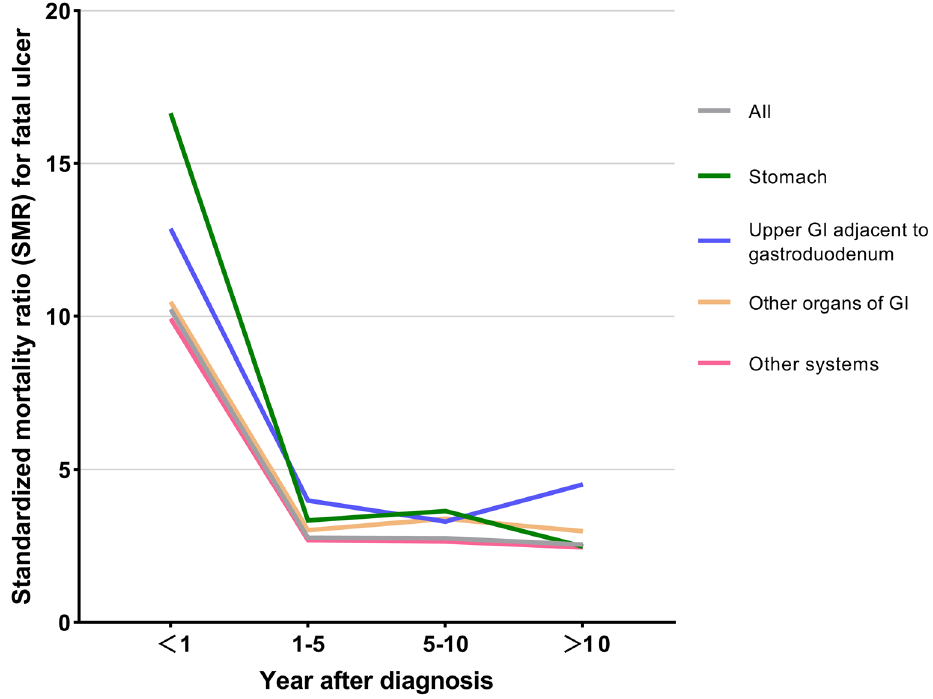
Figure 3. Standardized mortality ratios of fatal peptic ulcer were presented by cancer site and follow-up time. The upper gastrointestinal organs (GI) adjacent to gastroduodenum include the esophagus, small intestine, pancreas, liver, gallbladder, other biliary sites, and other digestive organs. The other organs of the GI include the retroperitoneum, colorectum, and anus. For most cancer types, the relative risk for fatal peptic ulcer was highest in the period immediately after cancer diagnosis, but this decreased rapidly thereafter. The SMRs for the upper digestive system malignancies adjacent gastroduodenum were significantly elevated 10 years after diagnosis, compared with that in other types of